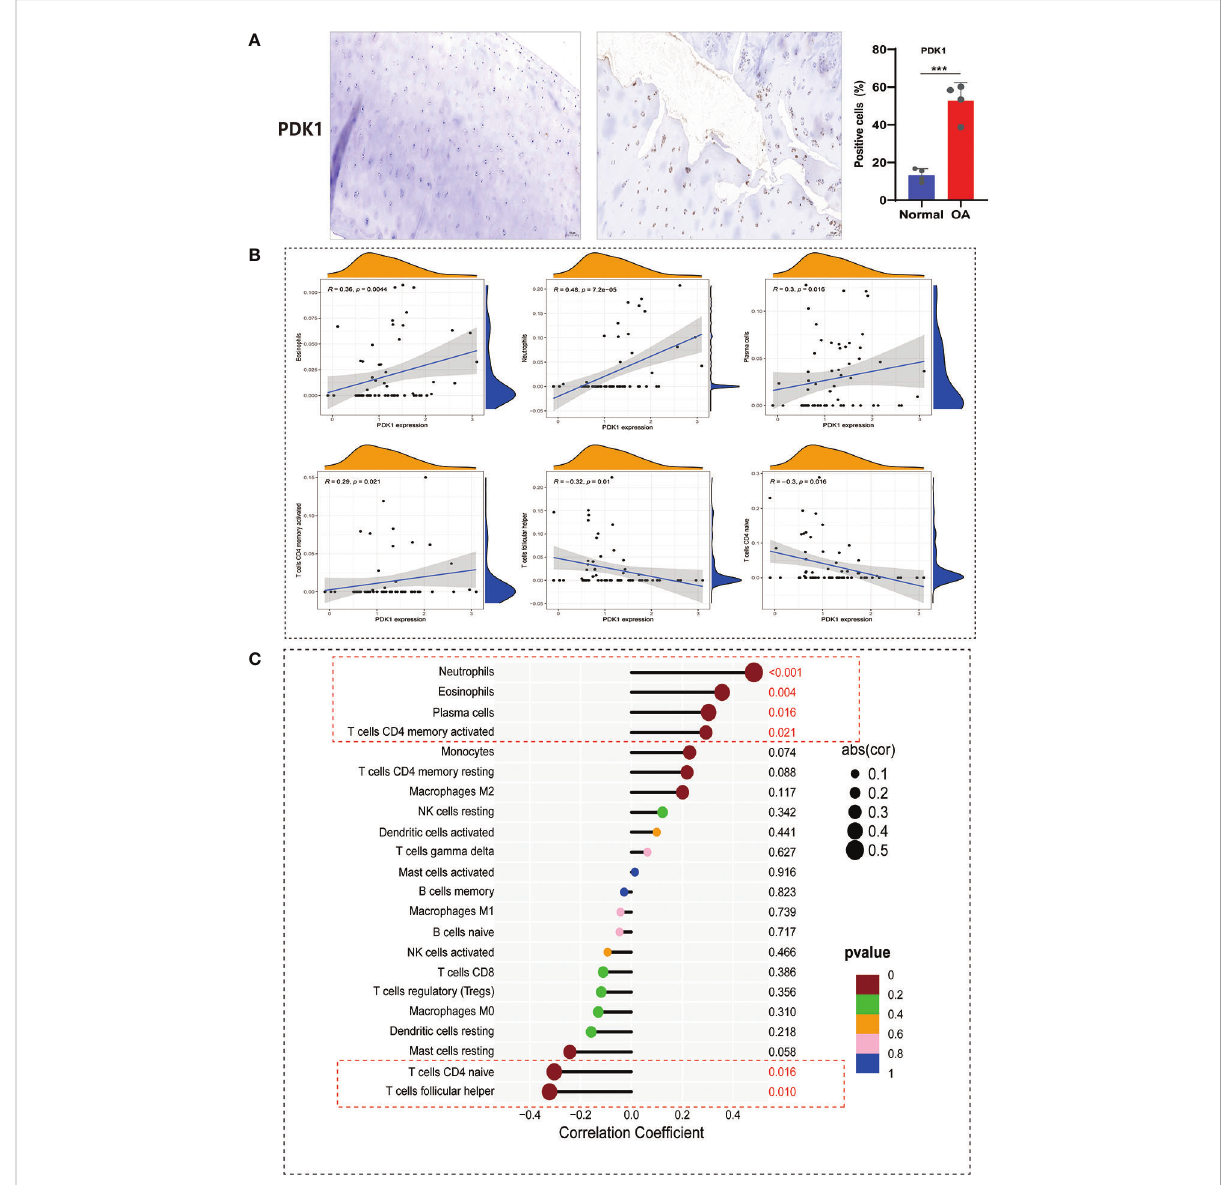
FIGURE 9 Correlation between PDK1 expression and immune cell abundance. (A) PDK1 immunohistochemical analysis between human normal cartilage and OA cartilage showed that PDK1 was highly expressed in OA tissues (means ± SD, n = 4,*** P < 0.001). (B) PDK1 expression levels were positively correlated with Neutrophils, Eosinophils, Plasma cells, and activated CD4 memory T cells and negatively associated with CD4 naive T cells and follicular helper T cells ( p < 0.05). (C) Lollipop plot for the correlation between PDK1 and 22 immune cells. A p < 0.05 was considered statistically signi fi